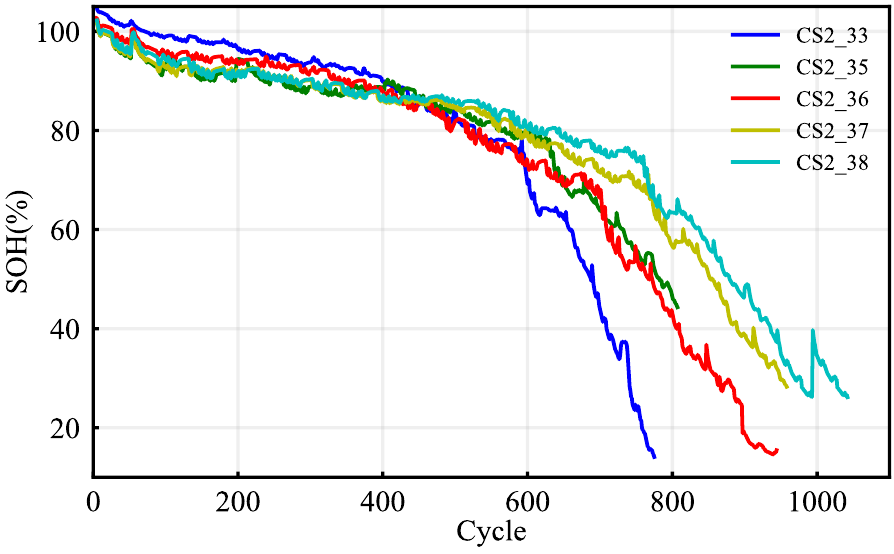
Figure 2. The SOH degradation curves during the whole life cycle.